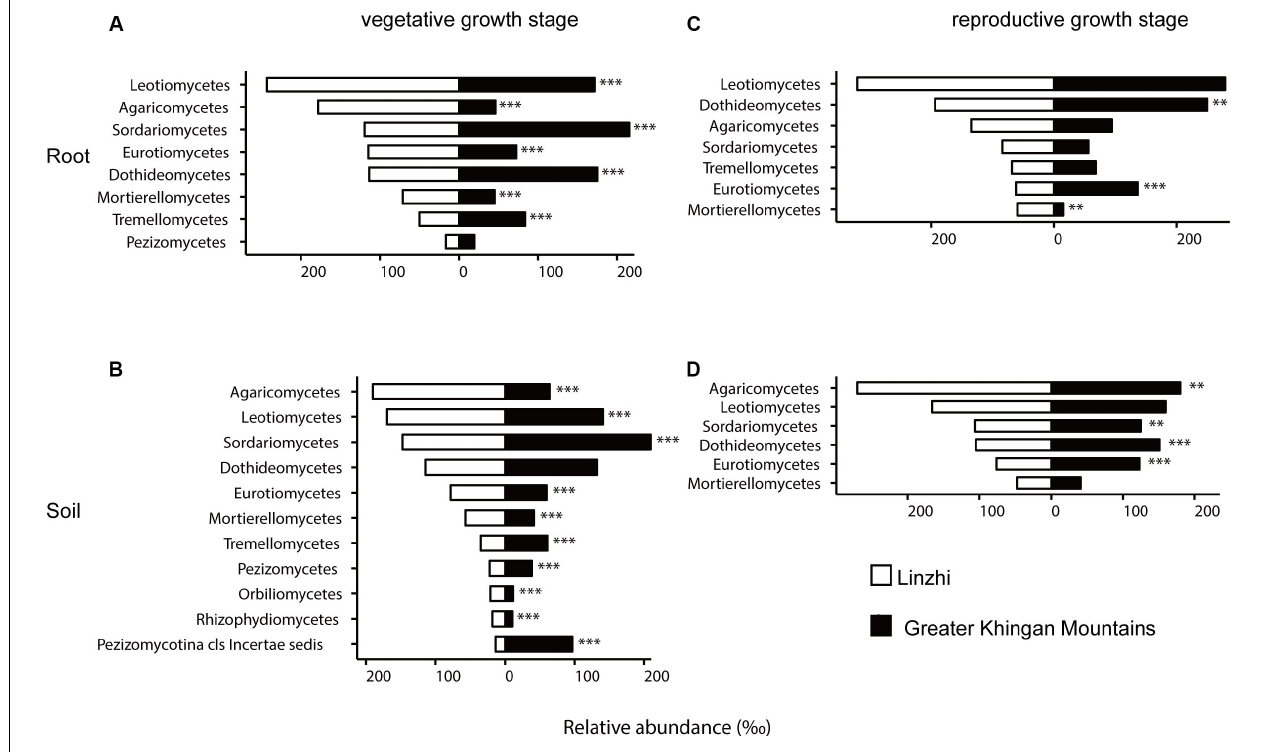
) of classes which made up at least > 10 (cid:104)